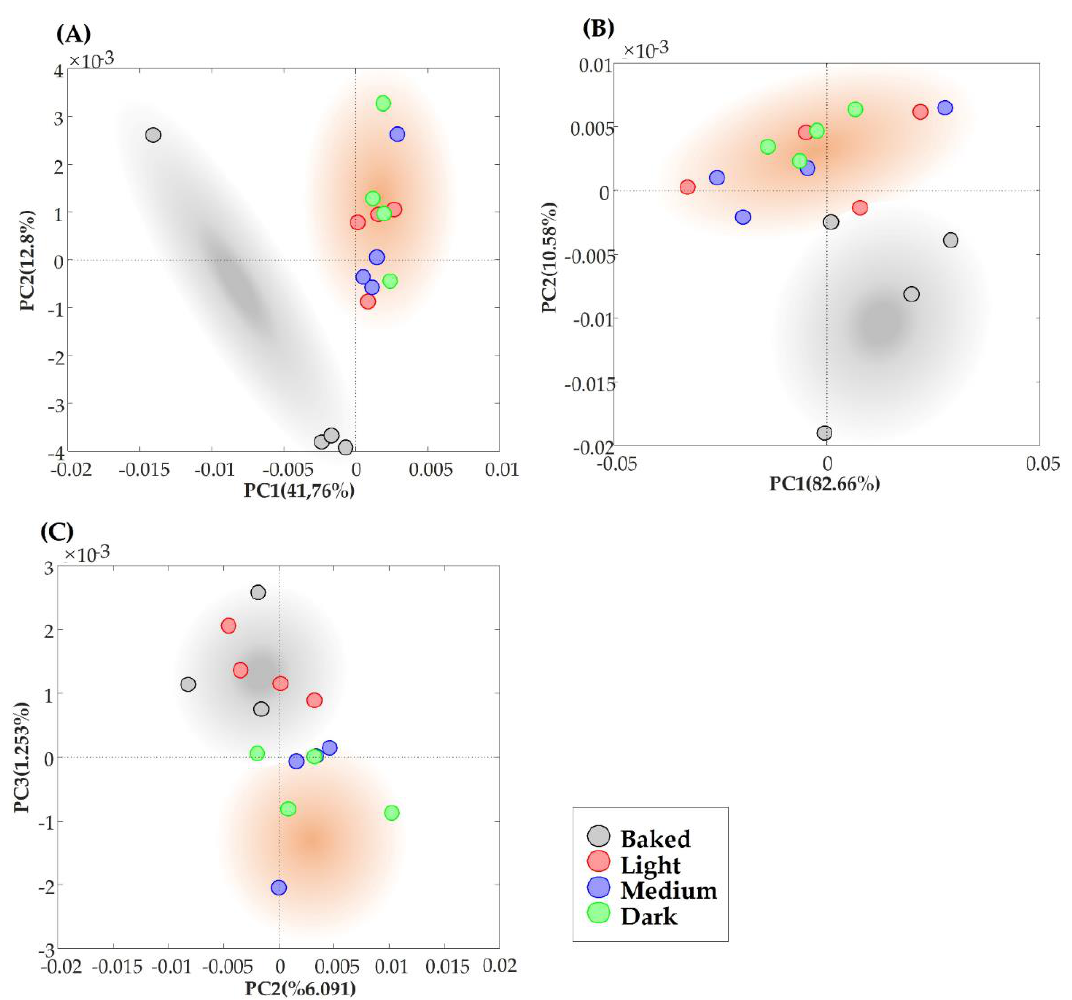
Figure 5. Interval Principal Component Analysis (iPCA) of infrared spectra in the IV ( A ), XIII ( B ), and V ( C ) intervals, as shown in Figure 3. These spectra are from samples of coffee roasted in different roasting profiles (baked, light, medium, and dark) using two roasters (Probatino and Golden Plus).